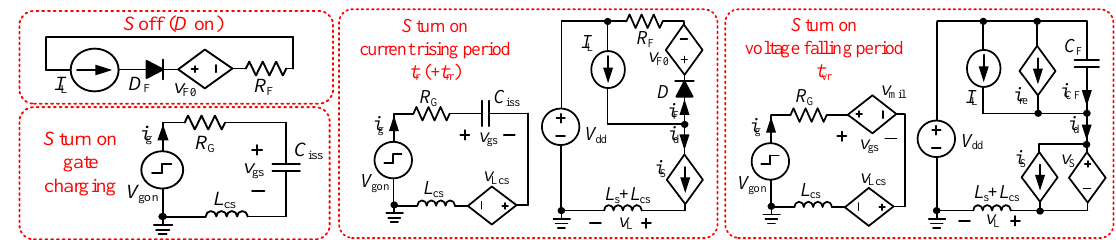
Figure 4. Simplified equivalent circuits during 𝑆 turn on transition.